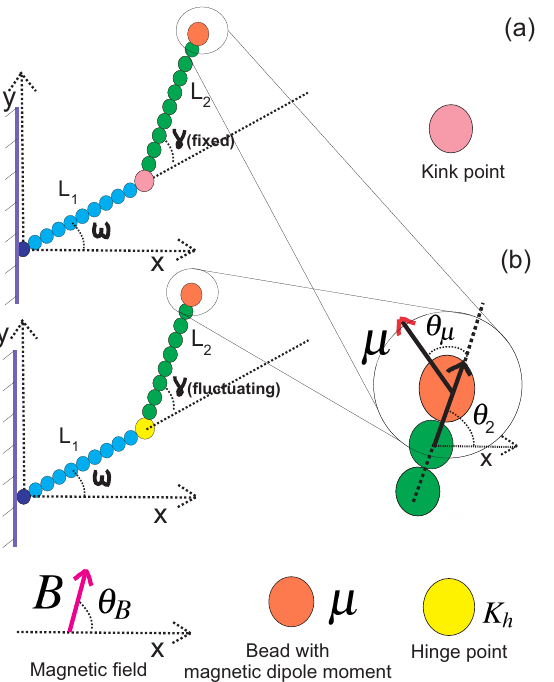
Figure 5. Upper panel ( a ): A configuration of two jointed weakly bending semiflexible filaments. The stiff joint (kink point) has a kink angle γ . The first filament has contour length L 1 and persistence length l p 1 . The second filament has contour length L 2 and persistence length l p 2 . The first filament is grafted onto a fixed substrate with a grafting angle ω . Lower panel ( b ): A configuration of two jointed semiflexible filaments with a hinge point. This differs from the system in the upper panel in that the kink angle γ fluctuates around an average value γ 0 . The hinge point has a rotational (bending) stiffness K h